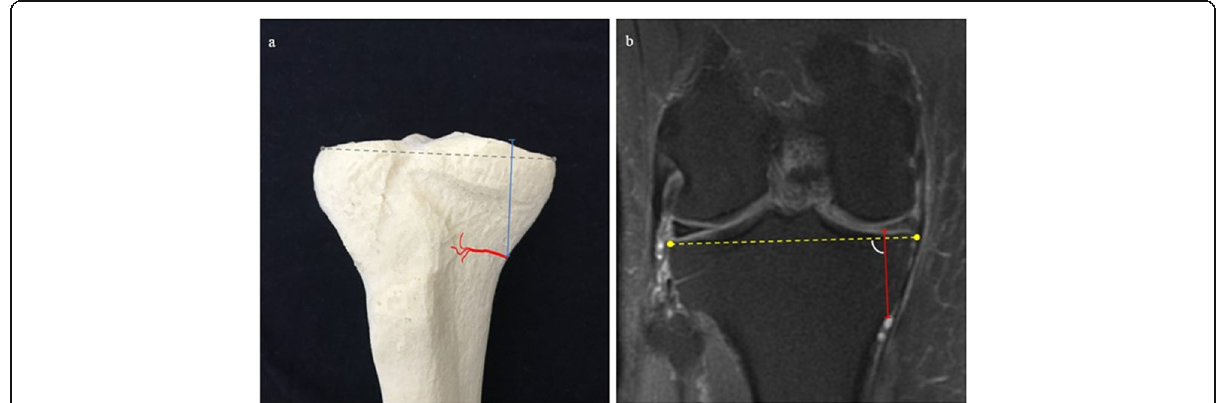
Fig. 3 a IMGA – JL Cor (blue) drawn on a 3D model. IMGA course in red and the reference line of the anterior tibial plateau in grey. b . IMGA-JL Cor on T2w with fat suppression coronal sequence (red)